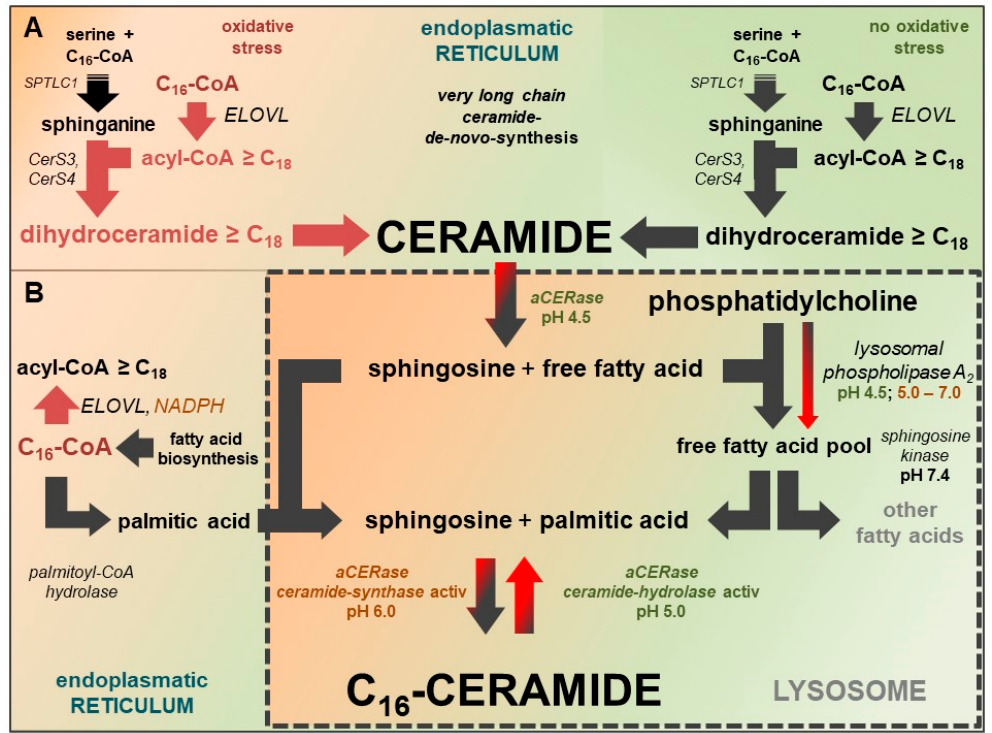
Figure 4. Linkage between synthesis of very long-chain fatty acids and very long-chain ceramides at the endoplasmatic reticulum and substrate supply of reverse ceramide synthase activity of aCERase for selective C 16 -ceramide synthesis in lysosomes. Active pathways at standard conditions are marked with black arrows, inactive pathways are marked with red arrows. Black and red arrows indicate pathways with diminished activity. ( A ) Very long-chain fatty acid synthesis at standard conditions (highlighted in green) and a lack of NADPH (oxidative stress) (highlighted in red). In cells lacking NADPH, C 16 -CoA is not converted to acyl-CoA ≥ C 18 and accessible to other reactions. ( B ) The potential sources of palmitic acid for the selective lysosomal synthesis of C 16 -ceramide by reverse ceramide synthase activity of aCERase are: hydrolysis of accumulating C 16 -CoA (palmitoyl-CoA hydrolase), hydrolysis of phosphatidylcholine (lysosomal phospholipase A 2 ), and sphingomyelin of cell membranes. Lysosomal phospholipase A 2 has residual activity, even at pH values up to 7.0.